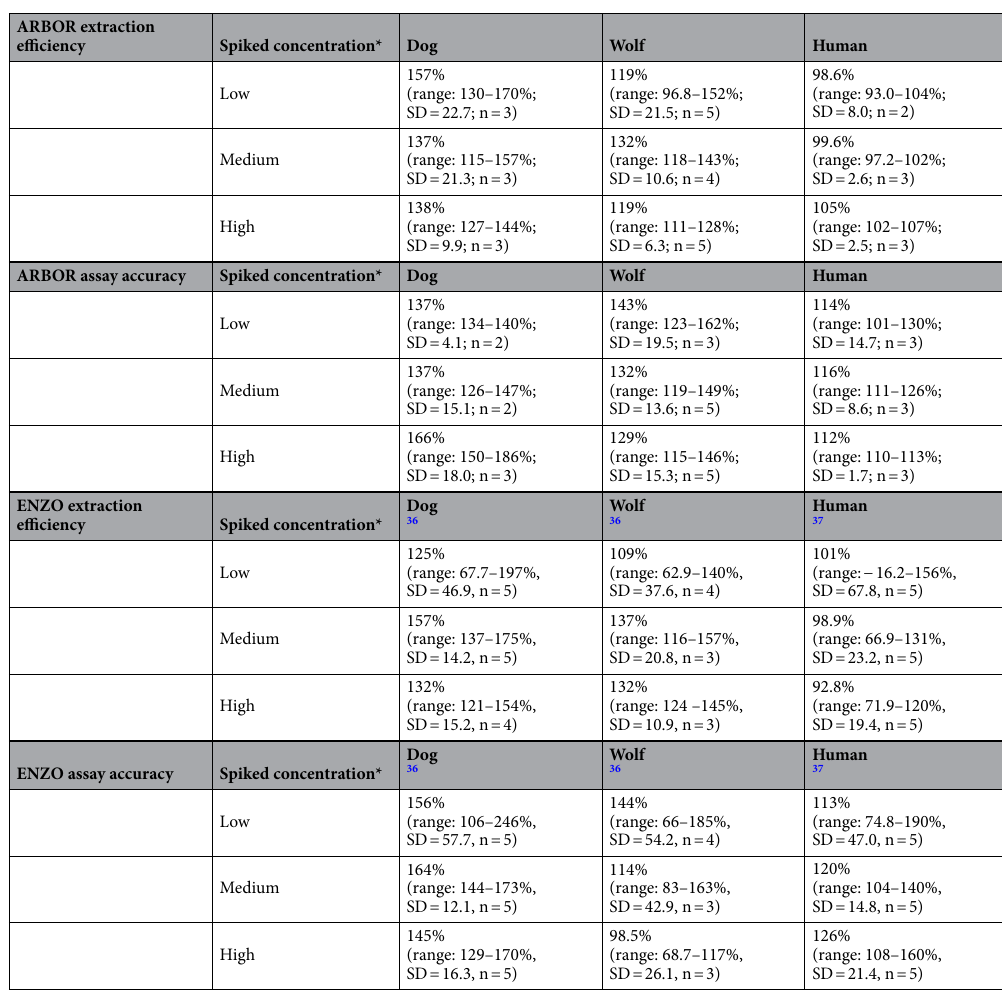
Table 2. Extraction efficiency and assay accuracy for the Arbor and Enzo assays. *237.5 µl pooled urine samples spiked with 12.5 µl of differently concentrated OT standard (high: 40,000 pg/ml; medium: 20,000 pg/ ml; low: 10,000